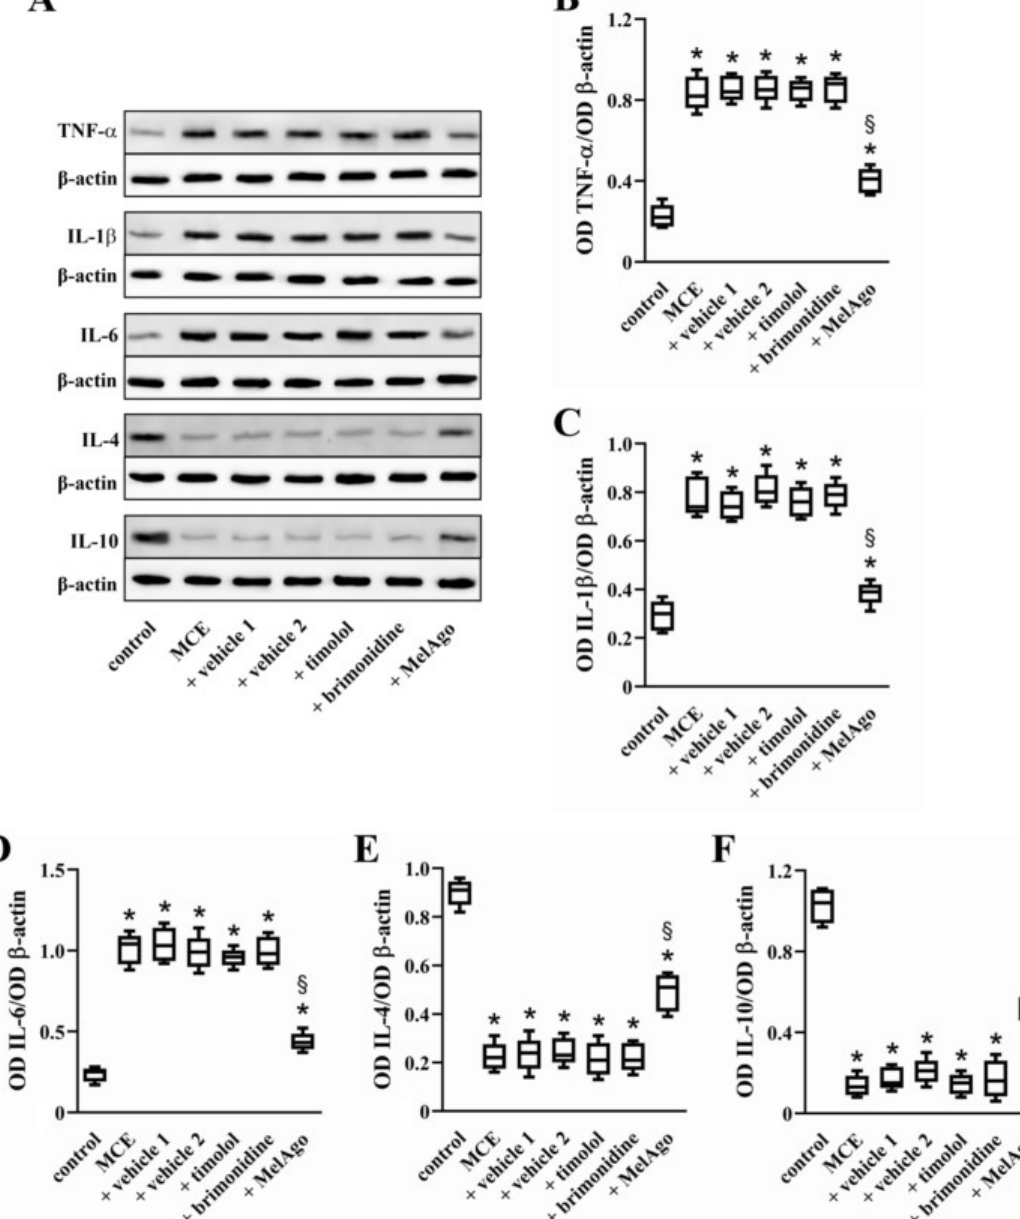
Figure 5. Levels of inflammatory markers. ( A ) Representative Western blots from retinal homogenates of control rats or rats that received MCE, either untreated or treated with vehicles, timolol, brimonidine or melatonin/agomelatine. ( B – F ) Densitometric analysis of the levels of tumor necrosis factor (TNF)- α ( B ), interleukin (IL)-1 β ( C ), IL-6 ( D ), IL-4 ( E ), and IL-10 ( F ). After MCE, the levels of TNF- α , IL-1 β and IL-6 were increased, while the levels of IL-4 and IL-10 were decreased. Vehicles, timolol or brimonidine did not affect the MCE-induced changes of the inflammatory markers, while melatonin/agomelatine almost restored their control levels. Data are shown as box and whiskers plots ( n = 6 samples, each containing 2 retinas, for each experimental group). * p < 0.05 versus control; § p < 0.05 versus vehicle 2 (one-way ANOVA followed by Tukey post-hoc test). MelAgo, melatonin/agomelatine.